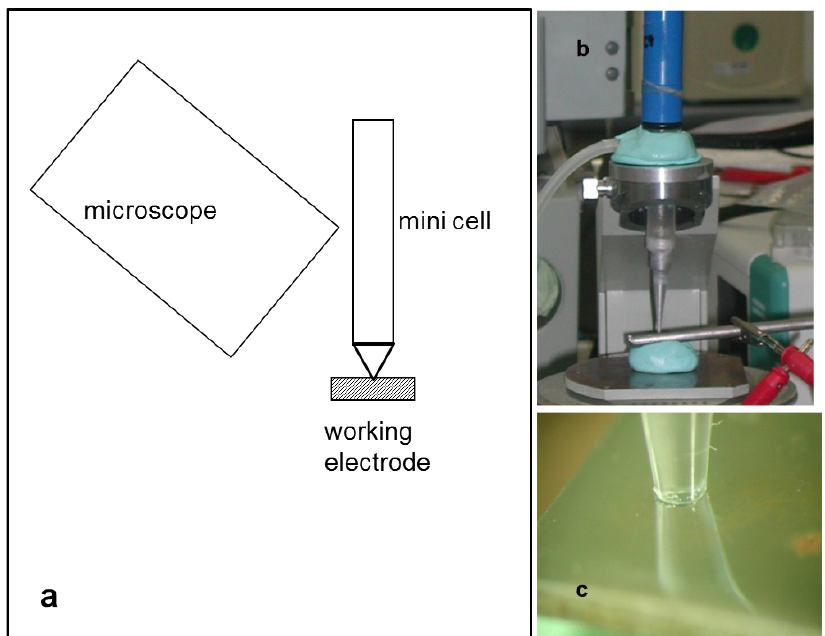
Figure 9. Setup of the measurement: ( a ) overview scheme; ( b ) mini-cell-system (MCS); and ( c ) stereo microscopic view of the measurement